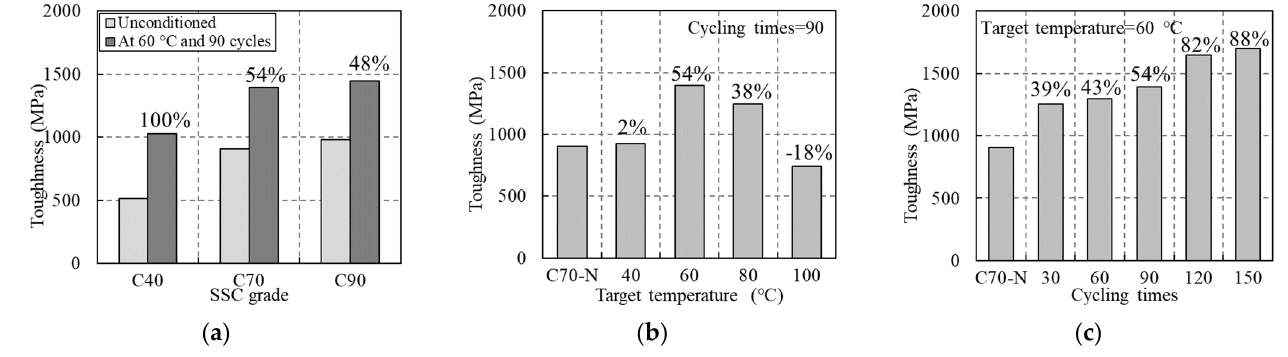
Figure 13. Toughness of SSC: ( a ) effects of SSC grade; ( b ) effects of target temperature; ( c ) effects of cycling times.